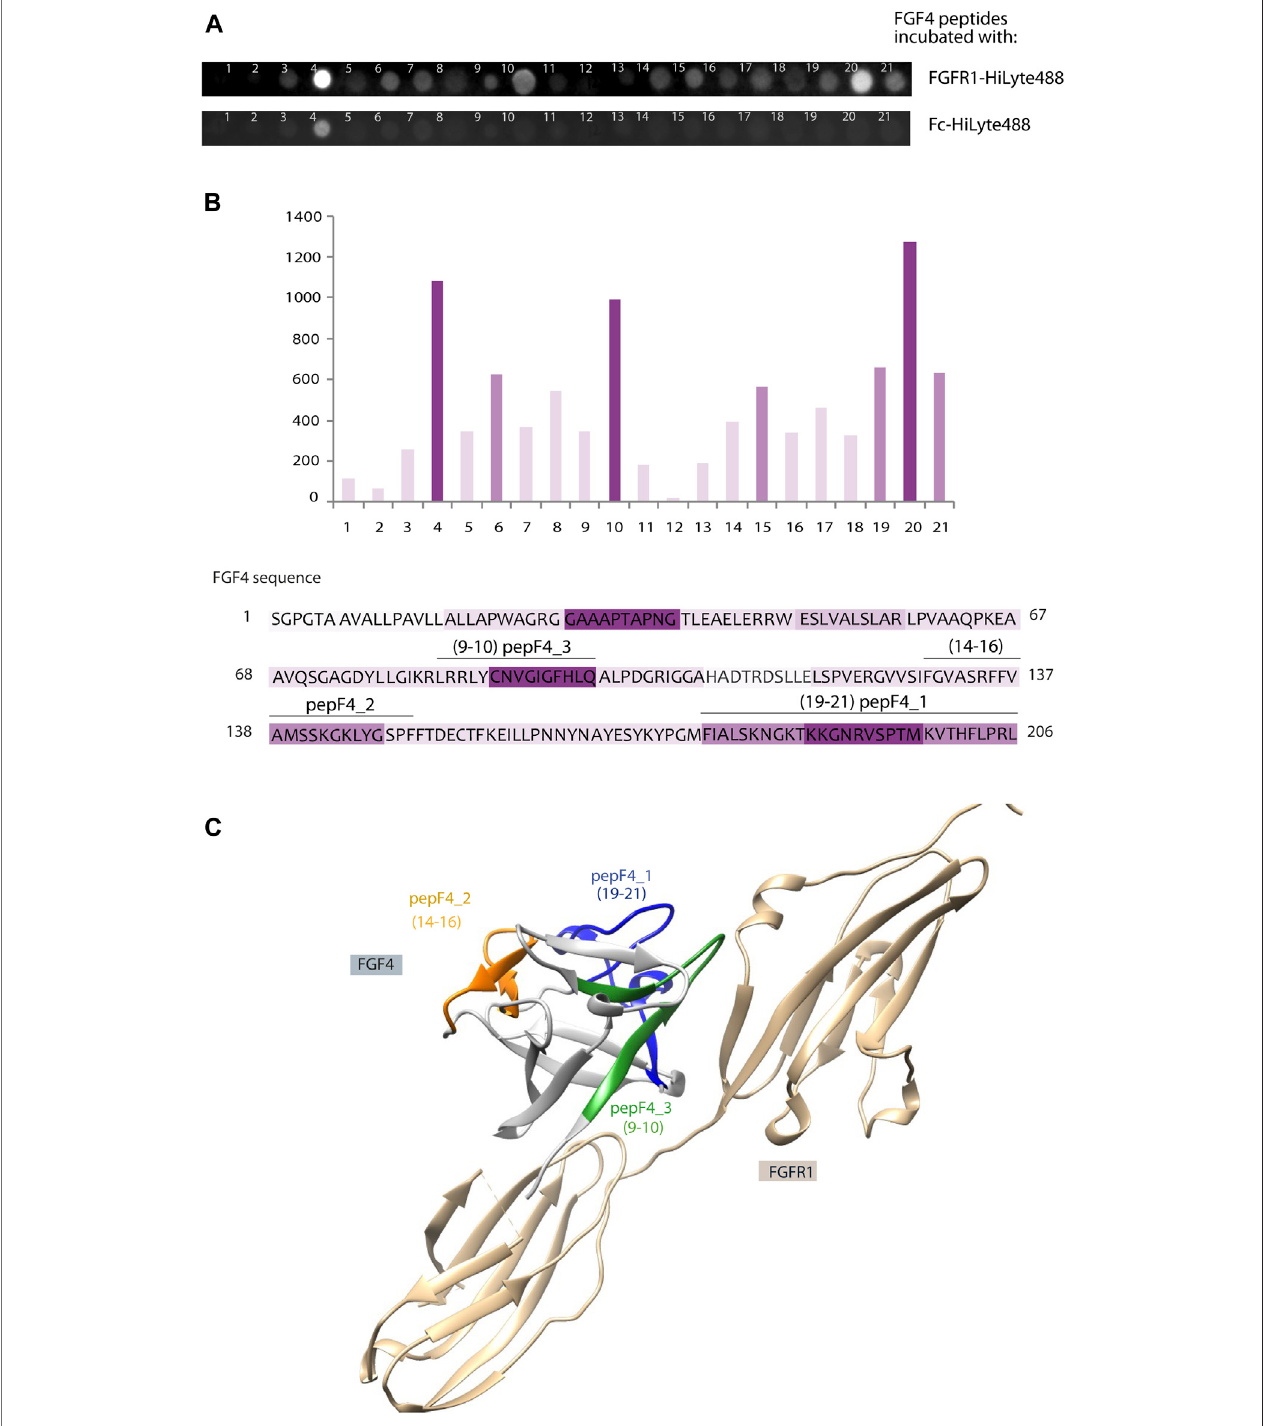
FIGURE 2 | Identi fi cation of new FGFR1-binding peptides using PepSpot assay. (A) Membrane with immobilized peptides spanning FGF4 sequence after incubation with fl uorescently labeled FGFR1 and Fcdomain. (B) Quantitative analysisof fl uorescence signals after incubation with FGFR1, performed using FijiSoftware (Shindelin 2012). The signal values after incubation with Fc-HiLyte488 were subtracted from the signal after incubation with FGFR1-HiLyte488. Intensities of bars ’ color correspond to the intensity of fl uorescence signal. Sequence of FGF4 was colored accordingly. (C) Model of FGF4 – FGFR1 interaction based on the structure of FGF1 – FGFR1 complex (PDB: 1EVT), with peptides F4_1, F4_2, and F4_3 marked in color on the FGF4 structure.